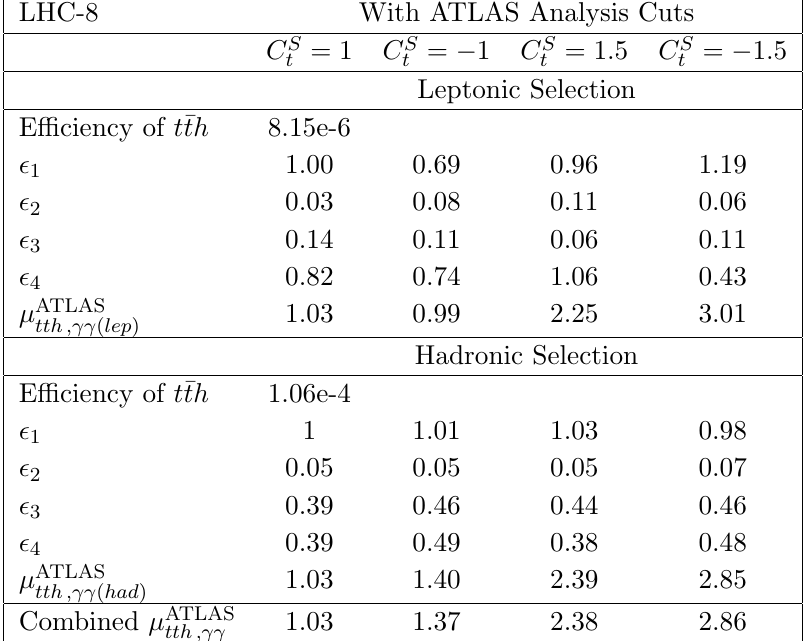
Table 8 . Category (cid:13)(cid:13) : the same as table 7 with the ATLAS cuts.